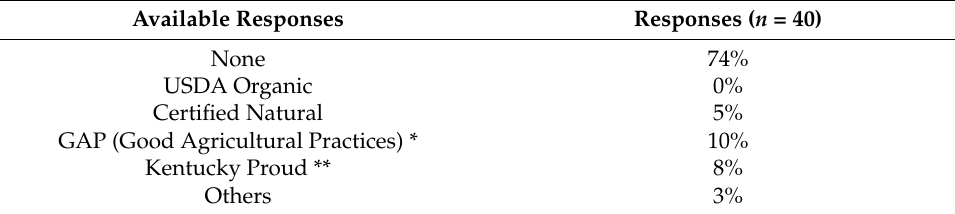
Table 2. Survey participants’ responses to the question, “Does your farm/garden have any